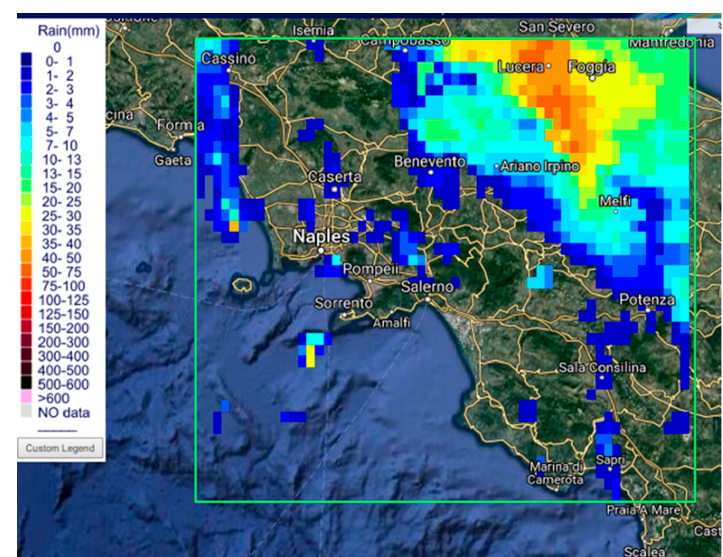
Figure 5. The Precipitation Estimation from Remotely Sensed Information using Artificial Neural Networks (PERSIANN)-Cloud Classification System (CCS) product acquired on 1 January 2018 and covering the same area associated with the HLS data shown in Figure 4.